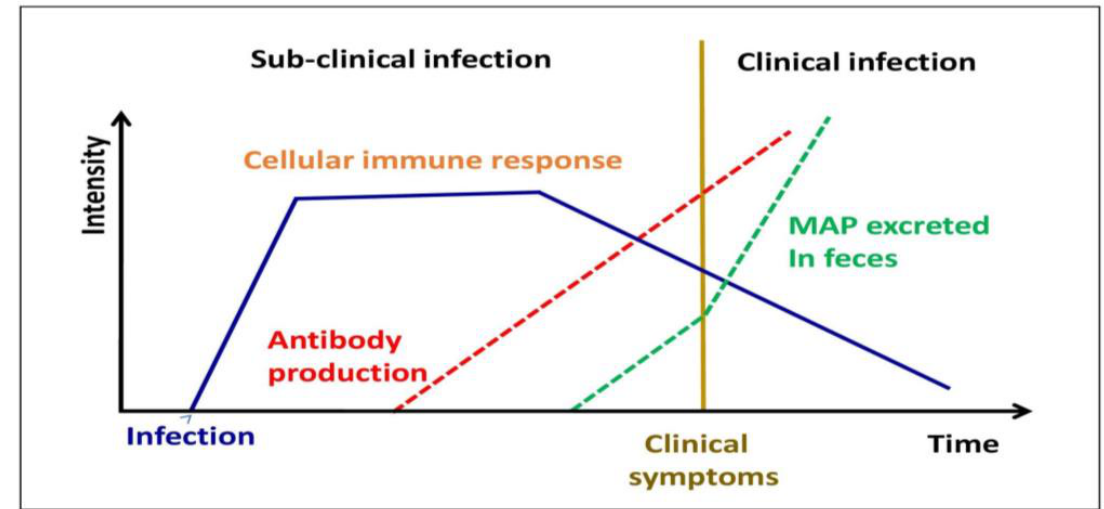
Figure 4. Different stages of MAP infection in domestic livestock.